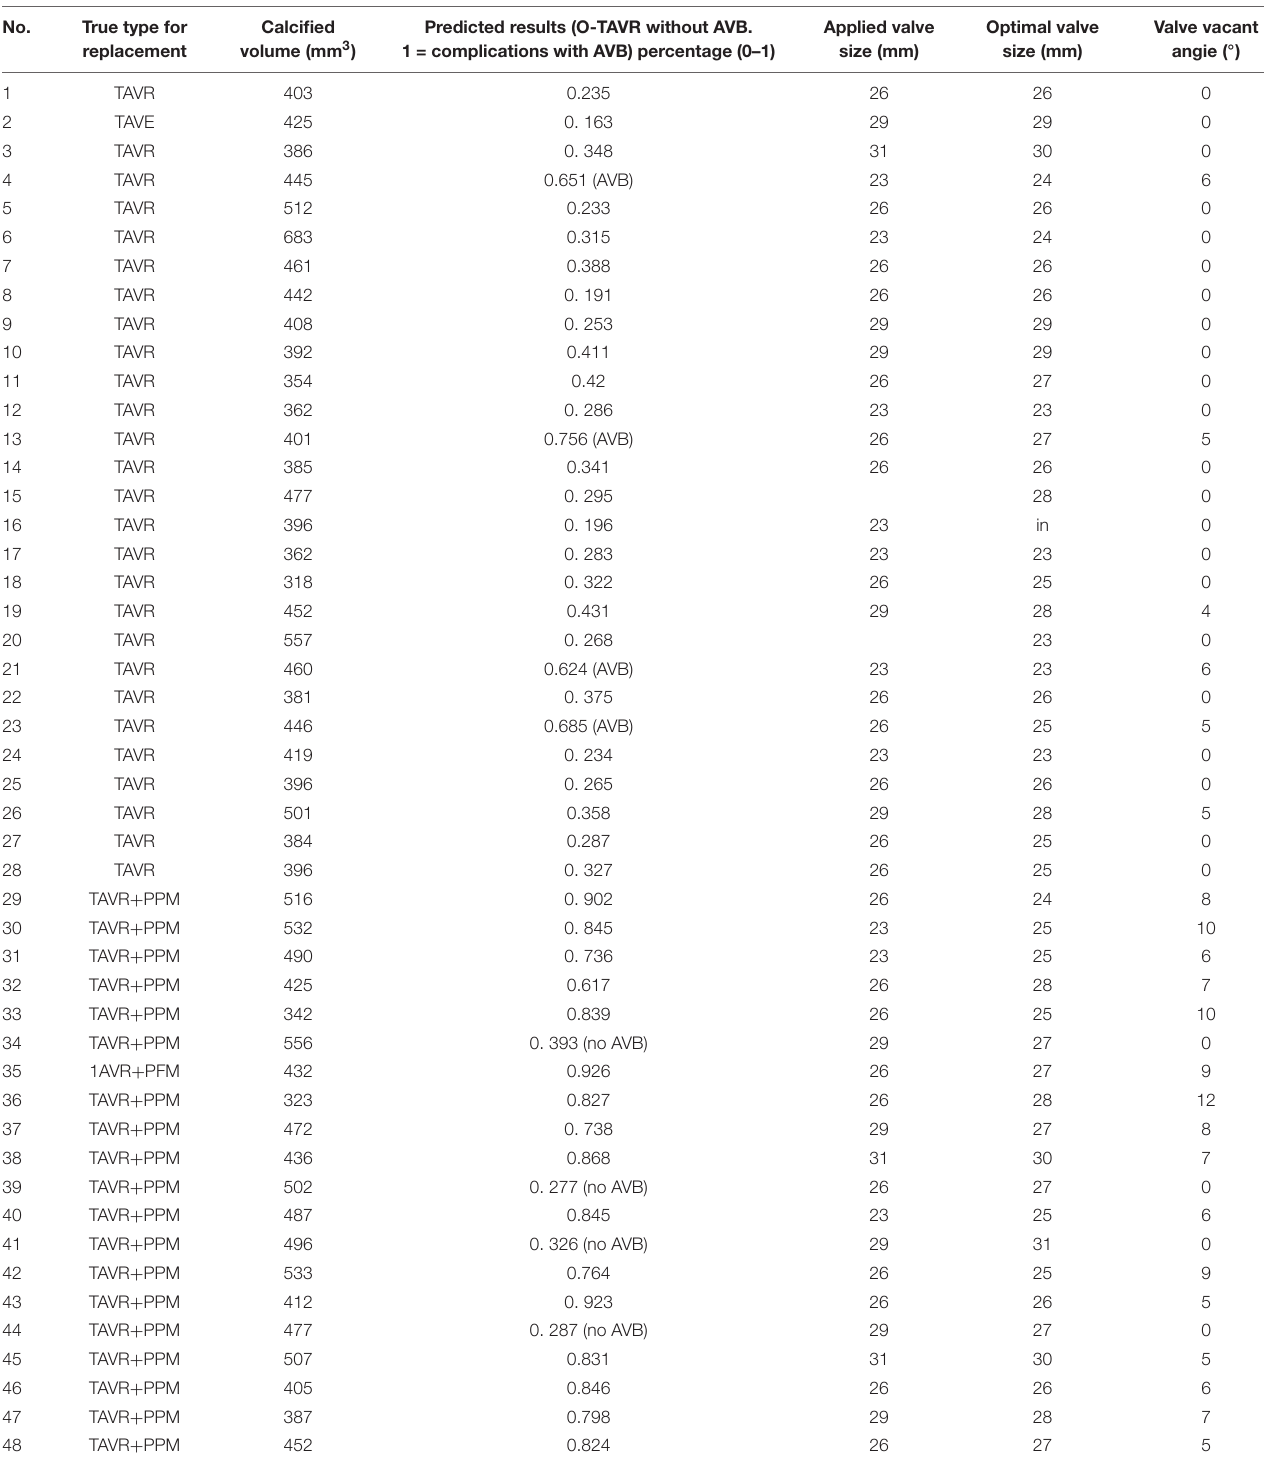
TABLE 2 | Prediction performance on two